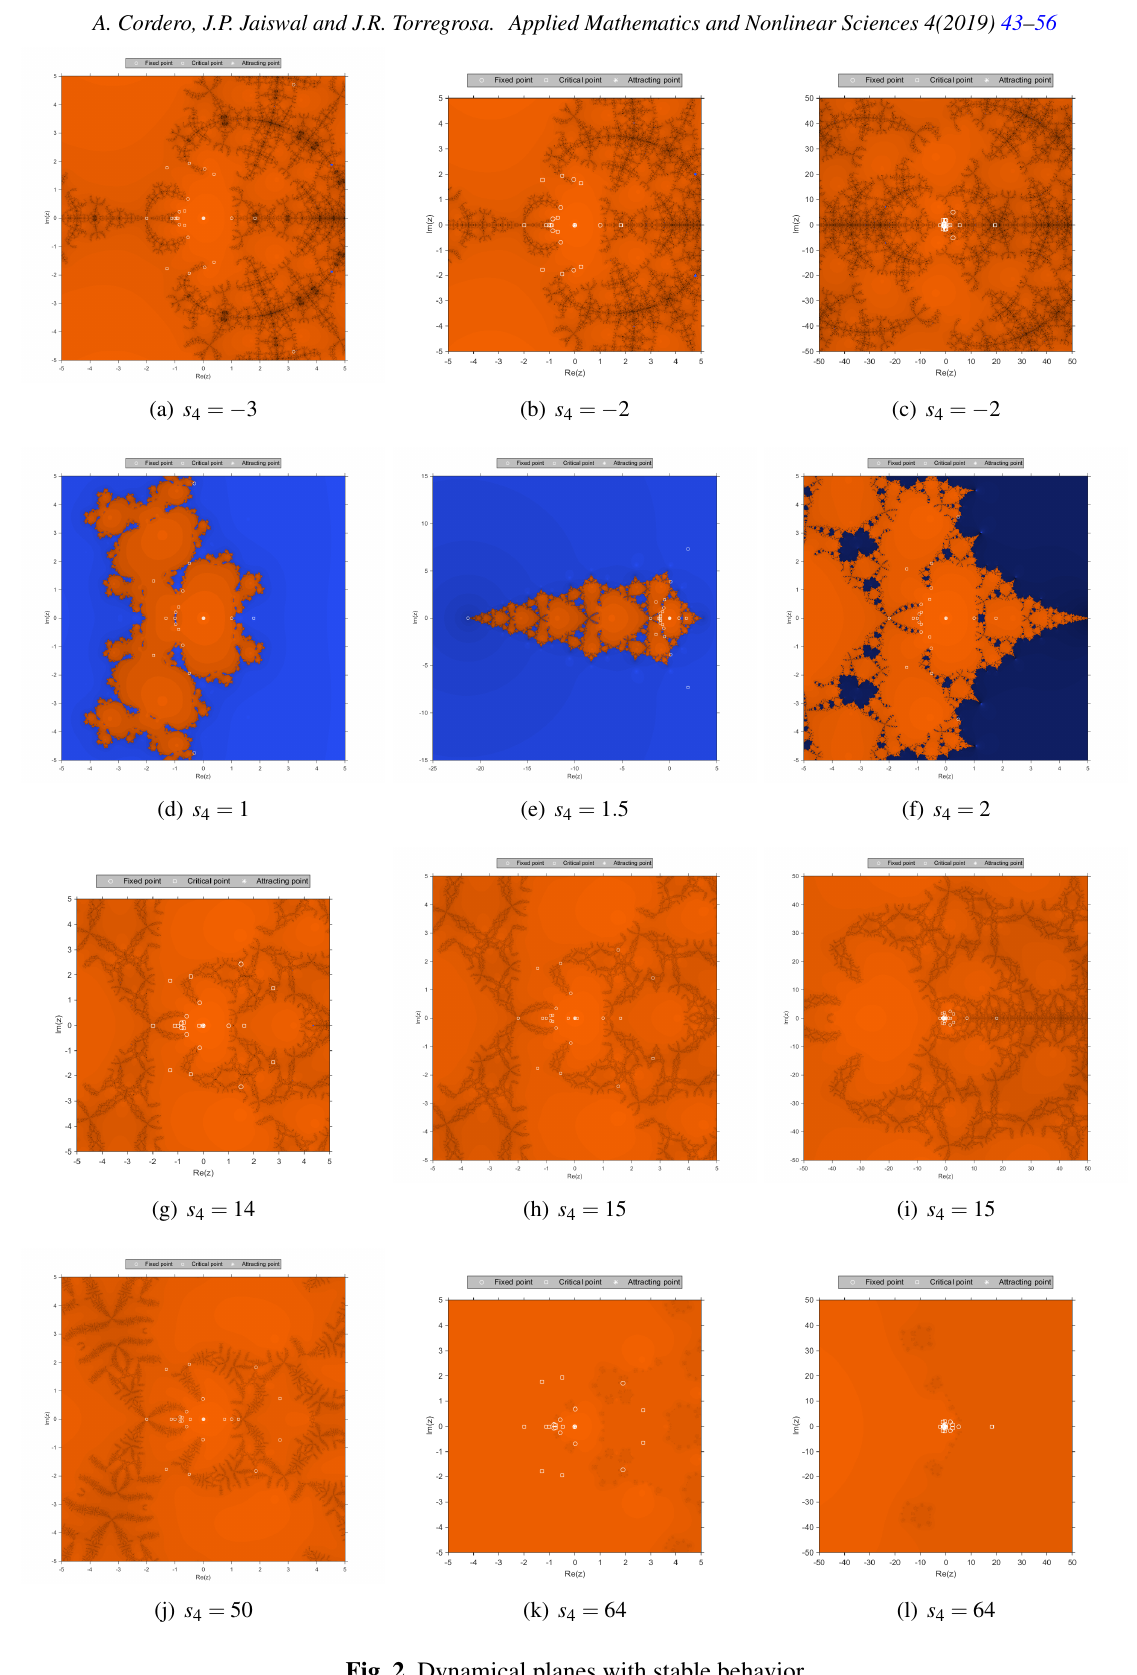
Fig. 2 Dynamical planes with stable